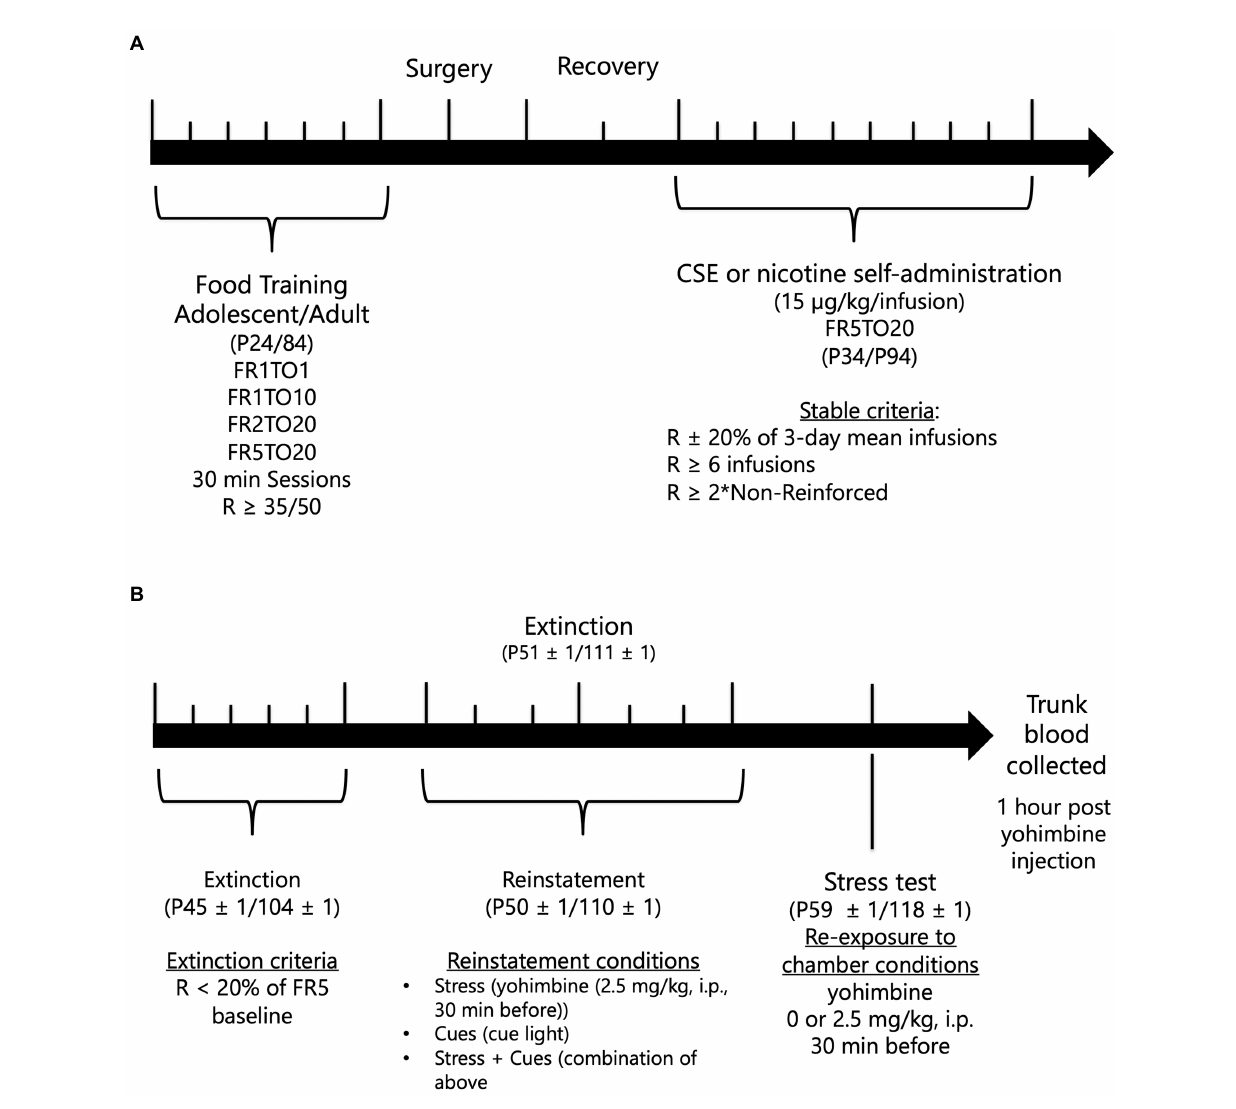
FIGURE 1 Timeline of behavioral experiment. A. Adolescent and adult rats underwent food training, catheter implantation, and self-administration of nicotine or CSE. B. After drug self-administration, extinction and stress-, cue-, and stress + cue-induced of nicotine- or CSE-seeking behavior before the final yohimbine exposure test